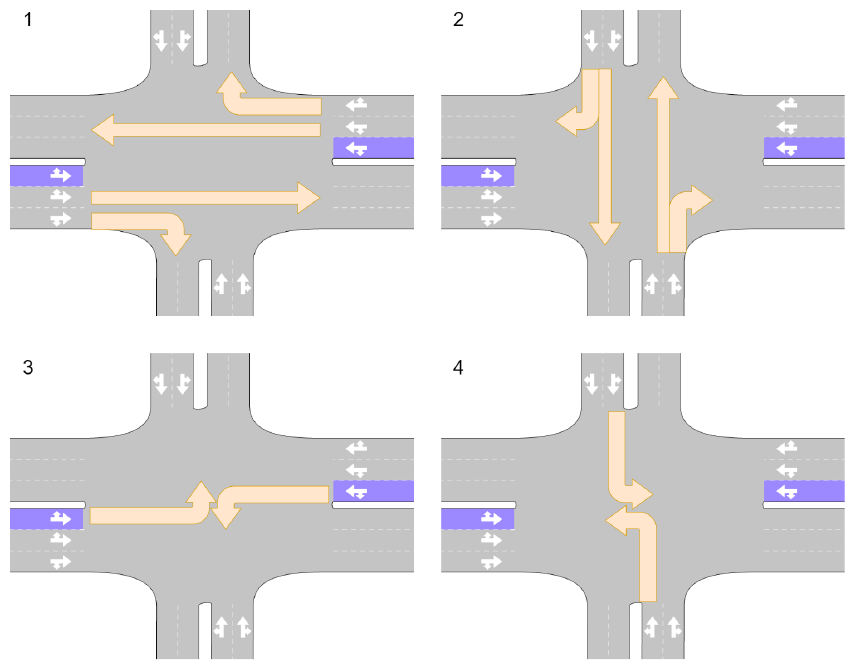
Figure 5. Demonstration of the signal groups. The signal groups for turning traffic are shown by orange arrows. Horizontal traffic and cars exiting a horizontal section through a right turn are served in signal group 1. Then, signal group 2 allows all left turns from the horizontal portions trough. Vertical traffic is handled in the same way in signal groups 3 and 4. The signal group can be switched and is not crucial for the subsequent